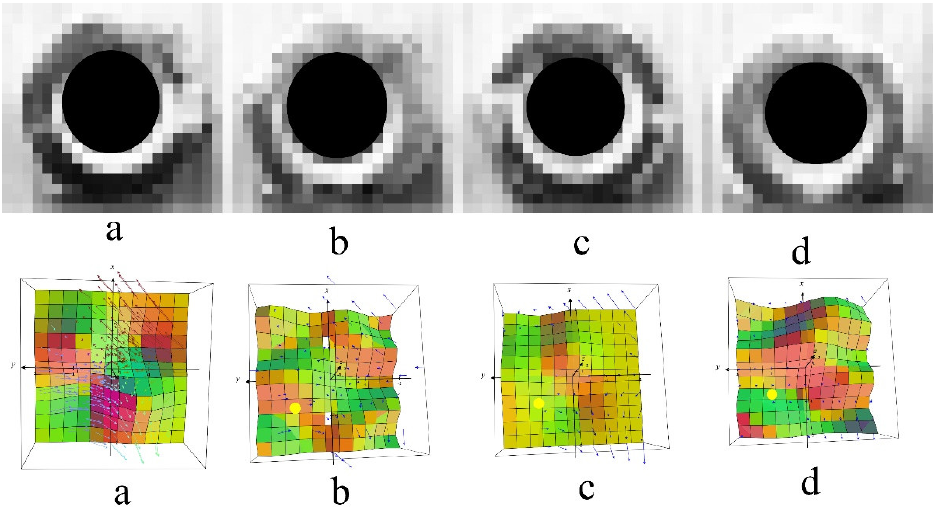
Figure 13. Analysis results of four different defective parts, with 3D graphic displays.